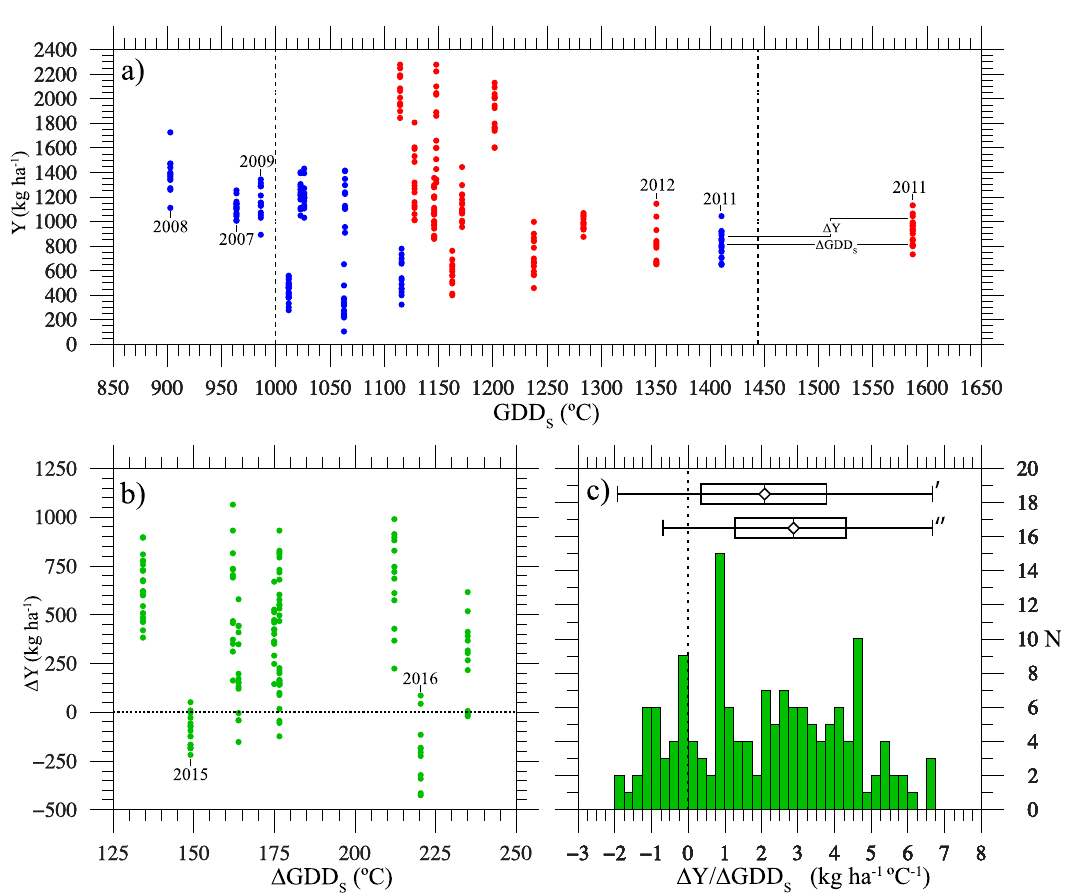
Figure 4. ( a ) Scatterplot showing May-planted (red) and June-planted (blue) lint yields on the Y-axis, and Equation (1) growing season cumulative growing degree days (GDD S ) on the X-axis. ( b ) Scatterplot showing May minus June yield effects ( ∆ Y) for each cultivar-year on the Y-axis, and the corresponding difference in May minus June-planted growing degree days ( ∆ GDD S ) on the X-axis. ( c ) Count histogram of the Y’ ratios ( ∆ Y / ∆ GDD S ) of the 153 scatter points in ( b ). Upper bar plot ( c’ ) marks percentiles of all 153 ratio values. Lower bar plot ( c” ) marks percentiles of 111 values when 2015 and 2016 ratios are omitted.